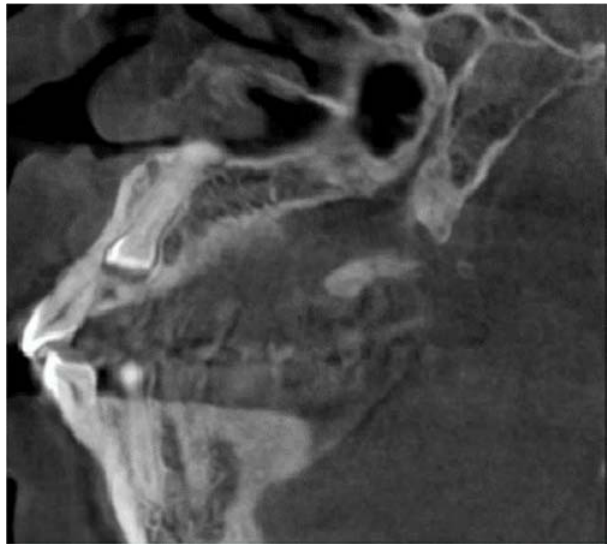
Fig. 1. Pre-operative